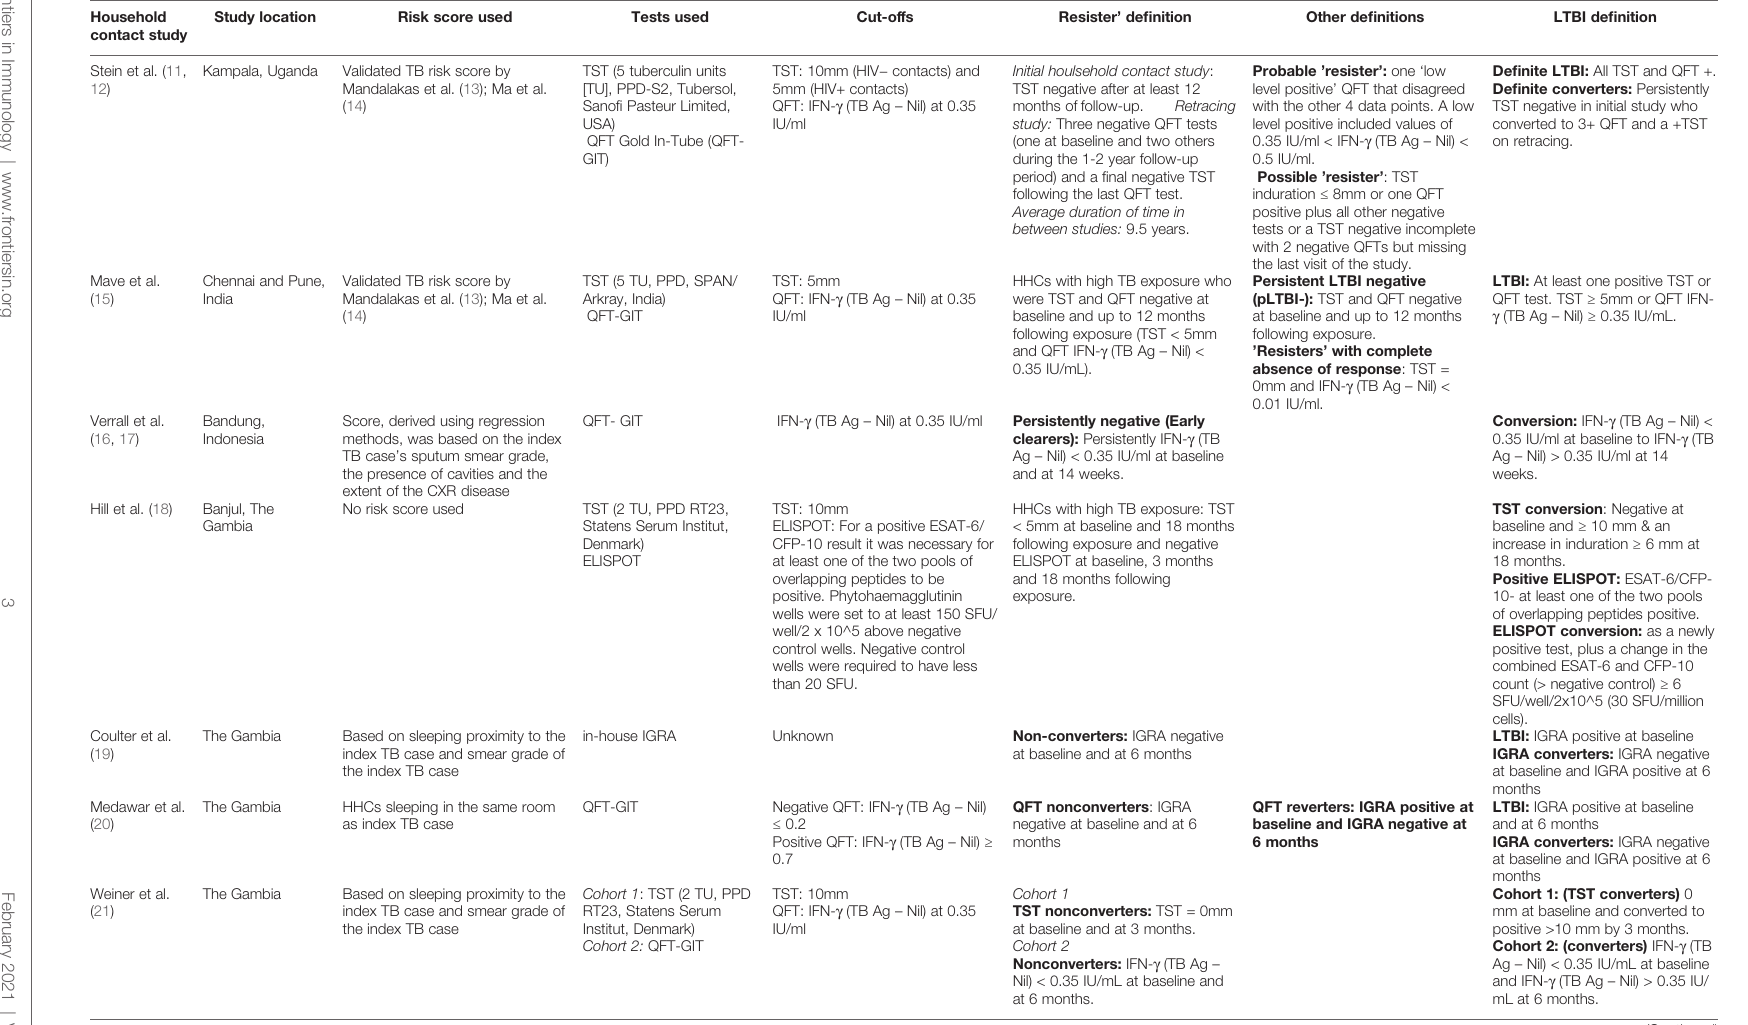
TABLE 1 | Summary of tests and de fi nitions used by household contact